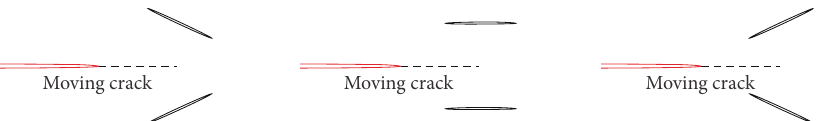
Figure 1: Three cases of a moving crack approaching a pair of symmetric precracks.